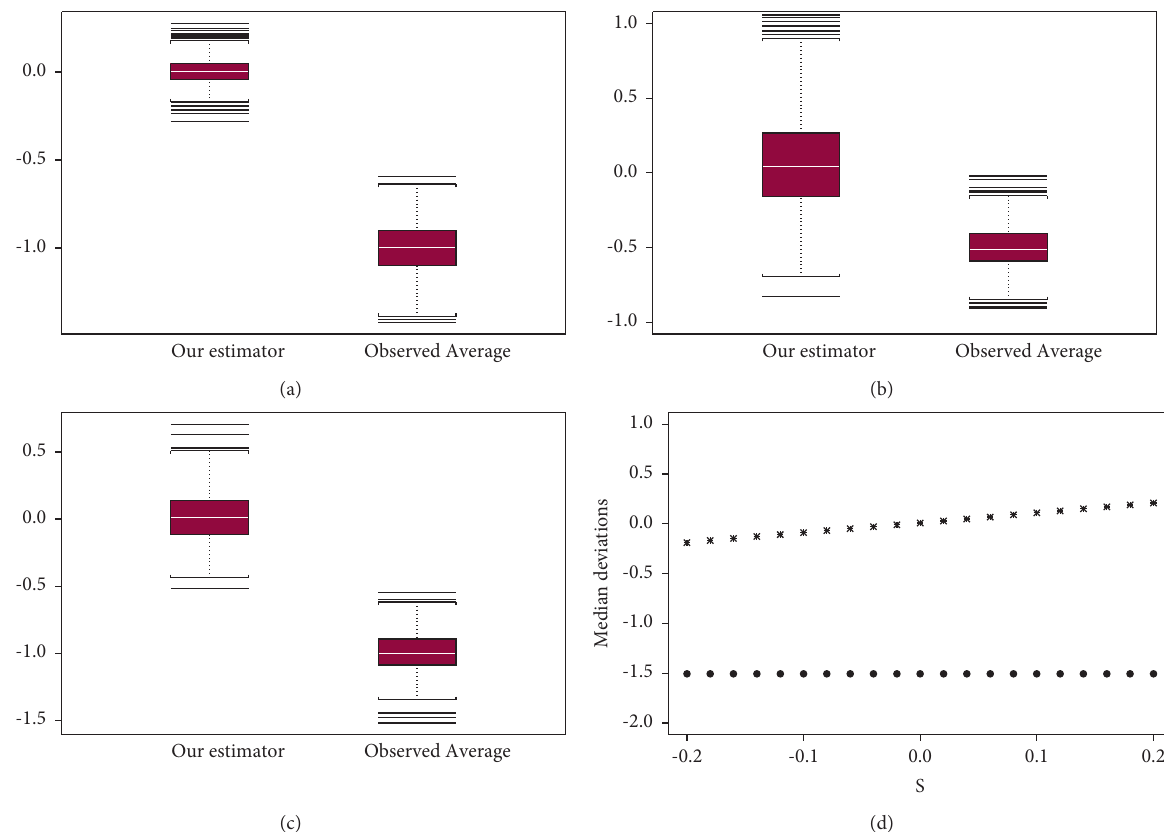
Figure 1: (a–c) The box plots of the distributions for the deviations of the estimators from the true mean among 600 simulations in Examples 1–3, respectively; (d) sensitivity analysis for Example 5. Dotted: the average of observed responses; –: our